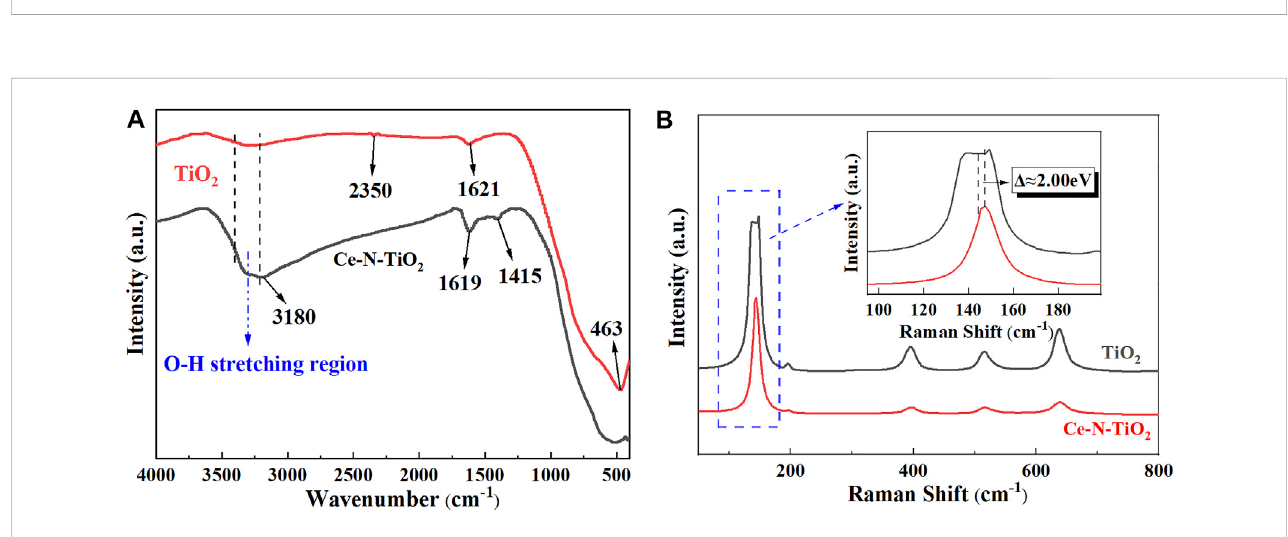
FIGURE 4 FTIR spectra (A) and Raman spectra (B) of TiO 2 and 0.5%-Ce-N-TiO 2